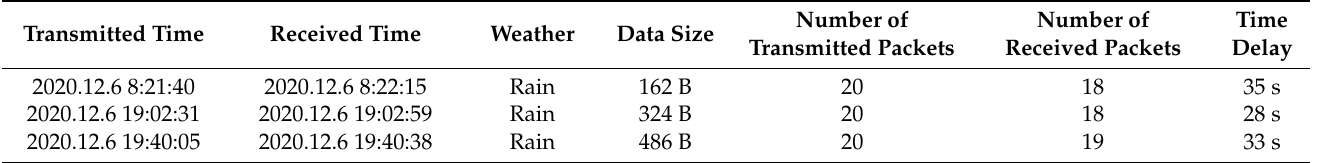
Table 3. System time delay (with the packet creation